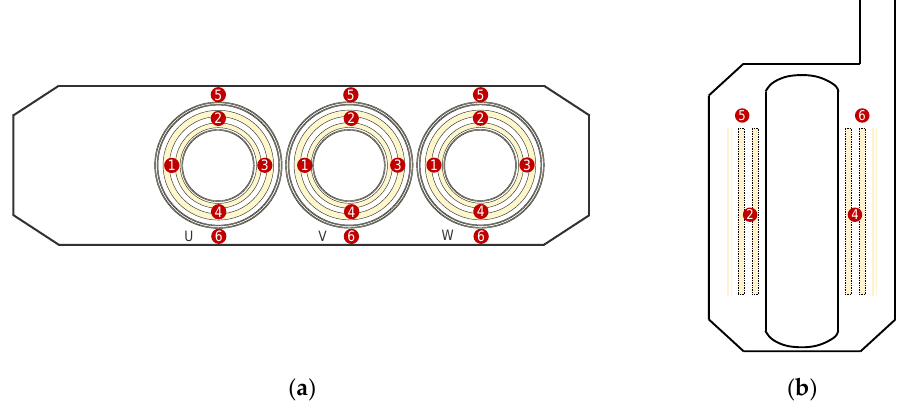
Figure 5. Location of the 18 artificial PD sources inside the transformer model. ( a ) Top view; ( b ) Side